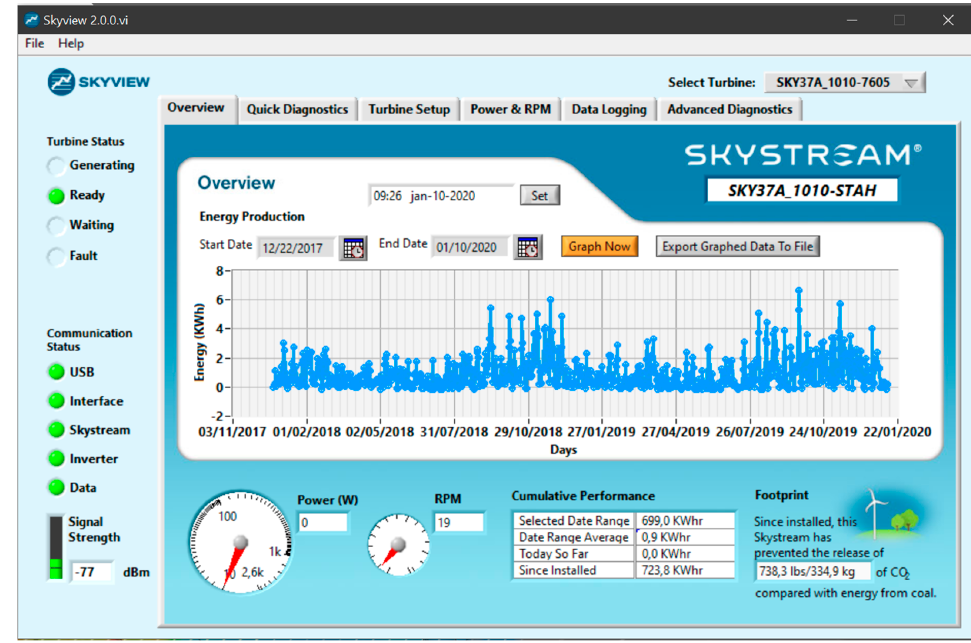
Figure 14. SWT’supervisor software Skystream ® screen